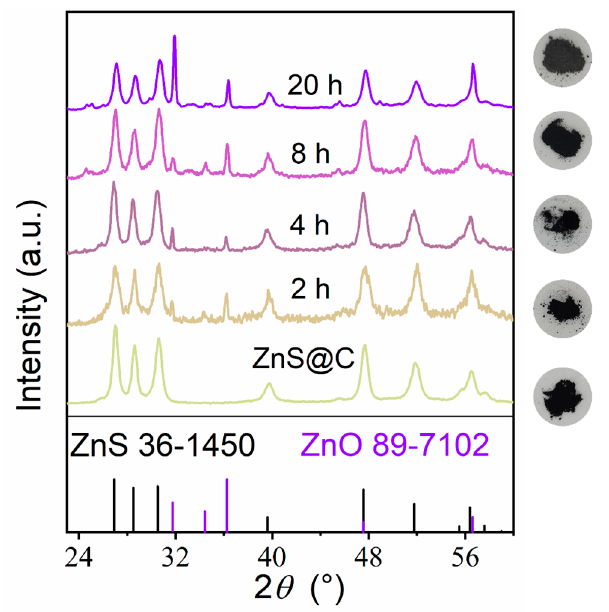
Figure 3. XRD patterns and photos of the ZnS@C samples after oxidation at 420 °C for various